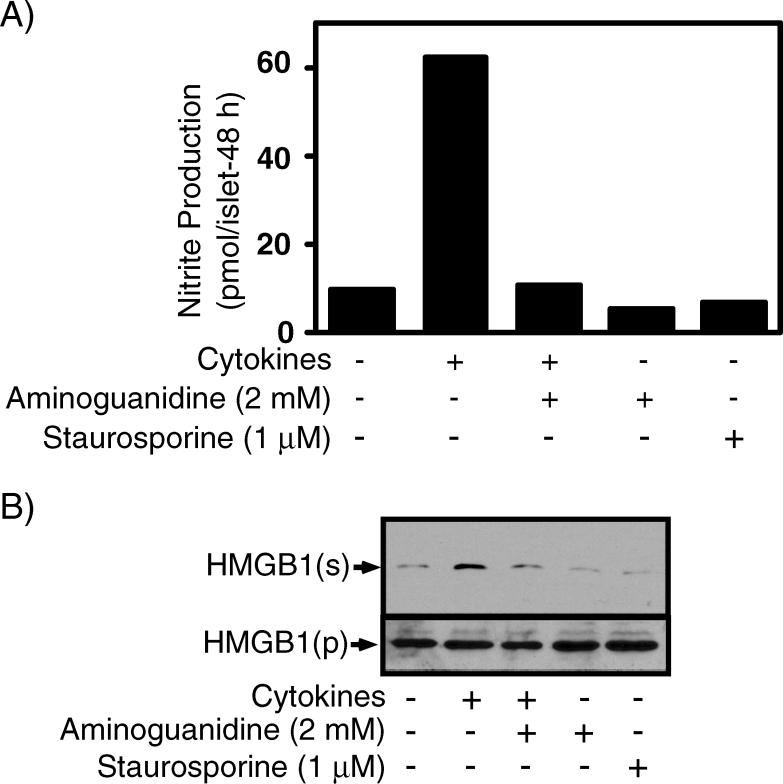
Nitric Oxide-Dependent Release of HMGB1 from Cytokine-Treated Human IsletsHuman islets (200 islets in 400 μl of complete CMRL-1066) were treated with a combination of IL-1 (50 units/ml), IFN-γ (500 units/ml), and TNF (50 nM) in the presence or absence of the NOS inhibitor AG (2 mM) or treated with staurosporine (1 μM) alone.(A) Following 48h -incubation the supernatant was removed and nitrite production was determined using the Griess assay. The levels of HMGB1 released into the supernatant (s) and contained in the islets (p) were determined by Western blot analysis.(B) Results indicate that cytokine-stimulated HMGB1 release correlates with nitric oxide production, and that inhibition of nitric oxide production using AG attenuates HMGB1 release from human islets. Similar results have been obtained in three of five independent preparations of human islets.